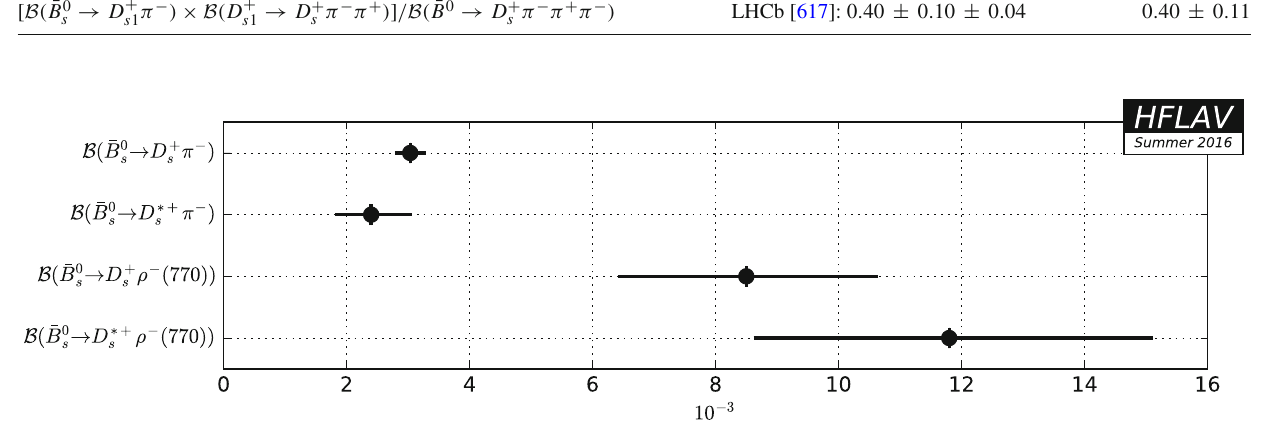
Fig. 152 Summary of the averages from Table